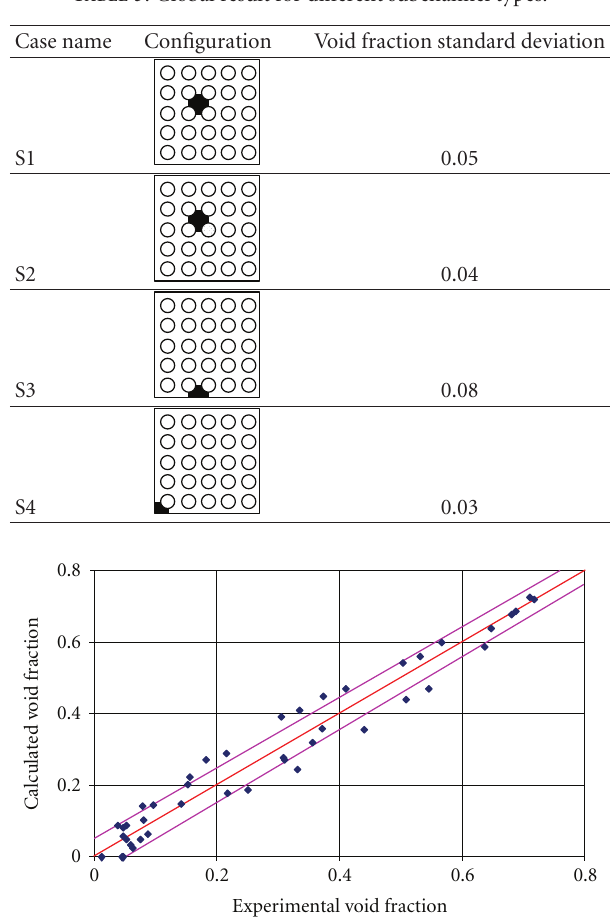
Table 3: Global result for di ff erent subchannel types.